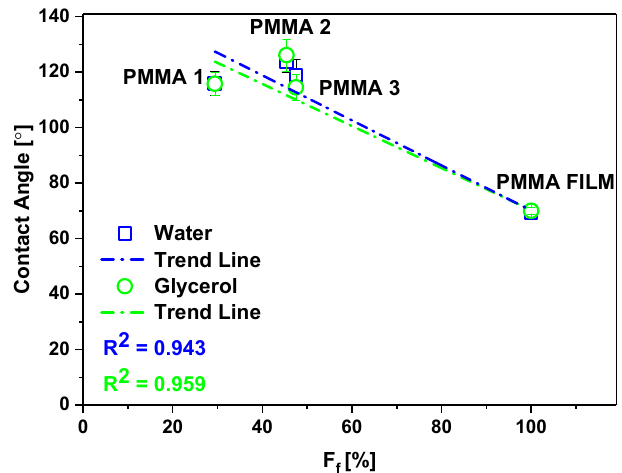
Figure 7. Changes in contact angle for water and glycerol on PMMA samples with a fraction of fibers in 3D meshes.